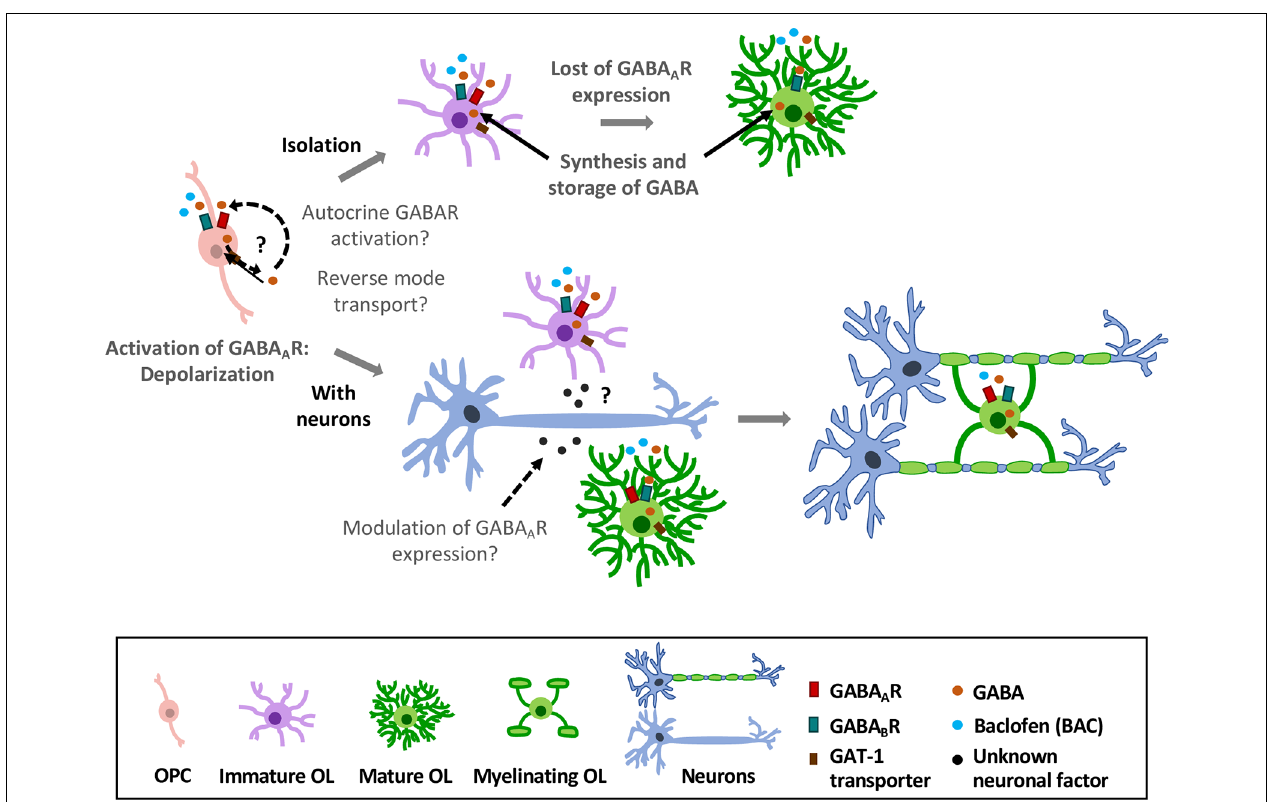
FIGURE 4 | Effects of GABAergic signaling in oligodendroglial differentiation and myelination. OPCs express GABA A and GABA B Rs. Activation of GABA A Rs causes depolarization in these cells (Kirchhoff and Kettenmann, 1992; Baraban et al., 2018). In absence of axons (top), they lose GABA A R expression as they differentiate into mature OLs (Berger et al., 1992; Arellano et al., 2016); however, expression of GABA B Rs is largely stable over time (Serrano-Regal et al., 2020). In the presence of axons (low), GABA A R expression is modulated by neurons, as OPCs maintain their expression towards the myelinating stage (Arellano et al., 2016). Moreover, oligodendroglial cells express GAT-1 transporter and synthesize GABA, which may be released by reverse GAT-1 operation and activate GABA receptors (GABARs) in an autocrine manner. Exogenous GABA or baclofen promotes oligodendroglial differentiation and myelination in vitro (Serrano-Regal et al.,